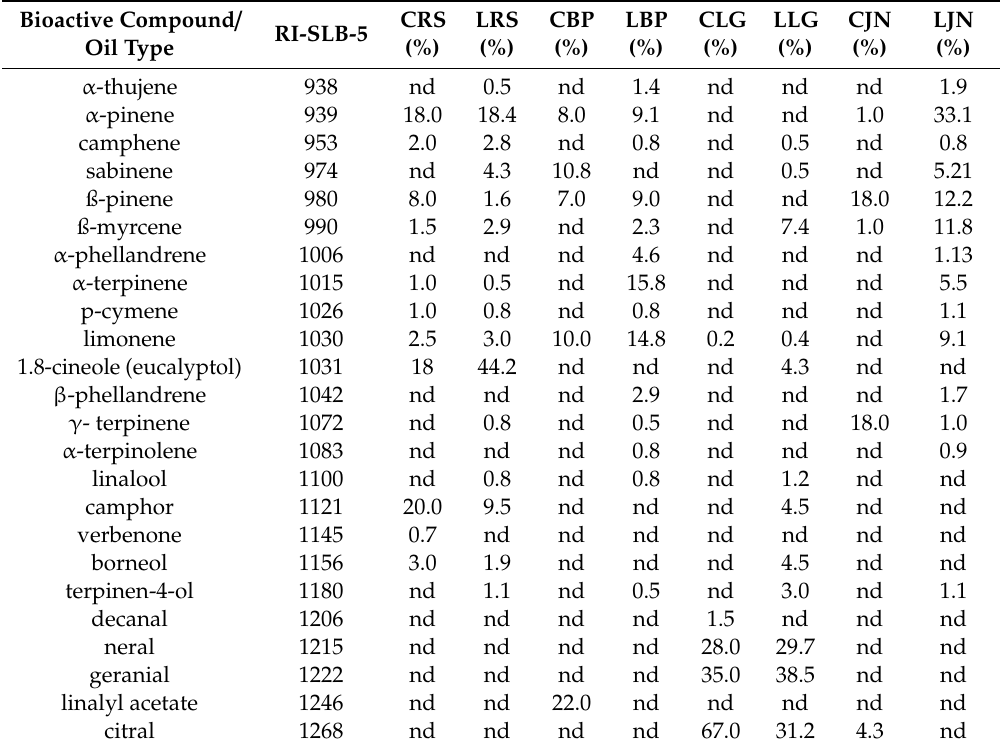
Table 2. The bioactive composition of both types of